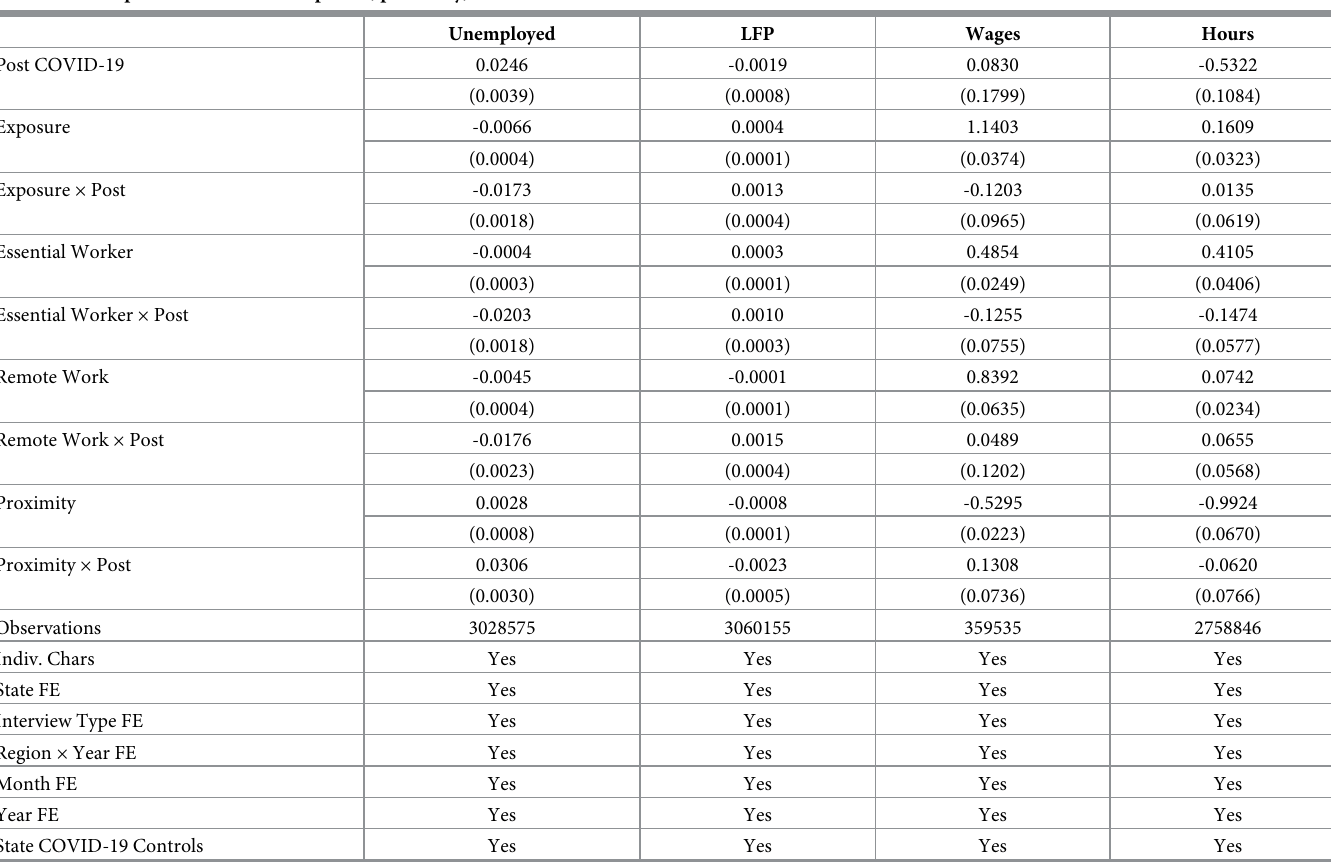
Table 9. The impacts of COVID-19: Exposure, proximity, remote work and essential